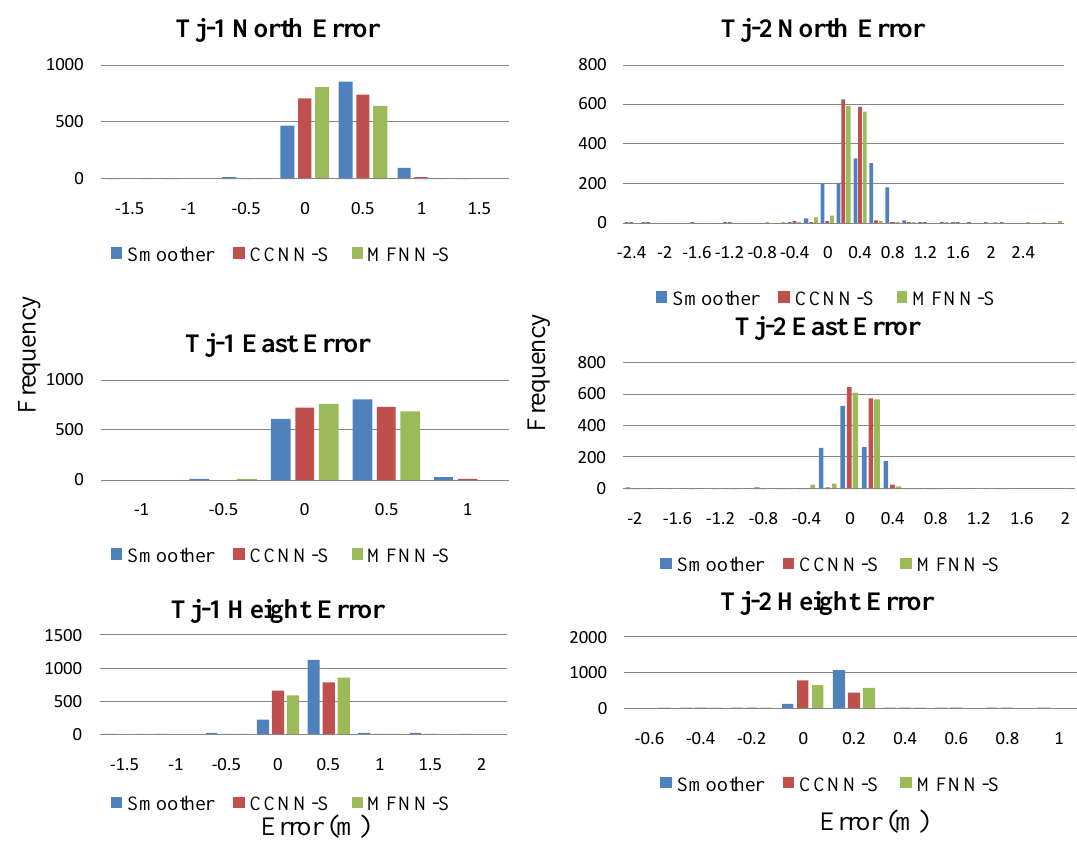
Figure 22. The histograms of positional errors (Testing